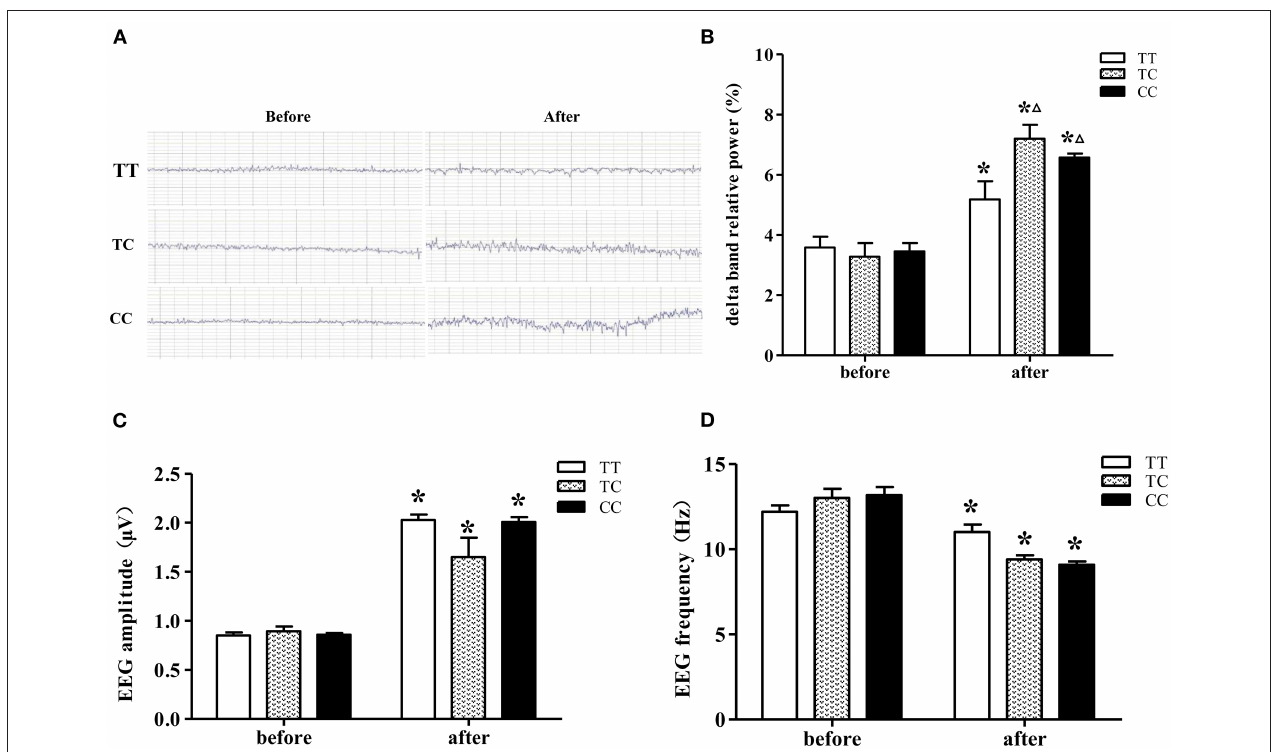
FIGURE 4 | EEGs from rats on the 14th day after 30 mW/cm 2 microwave exposure. (A) EEG. (B) Delta band relative power. (C) Amplitude. (D) Frequency. Statistical significance (repeated measures ANOVA); changes in the TC and CC genotype groups: 1 P < 0.05 vs. the TT genotype group. * P < 0.05 vs. prior to exposure.